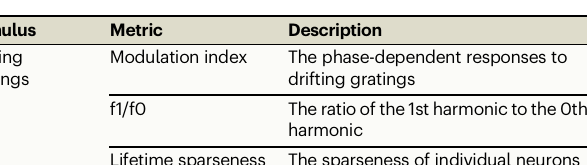
Table 2 | Stimulus